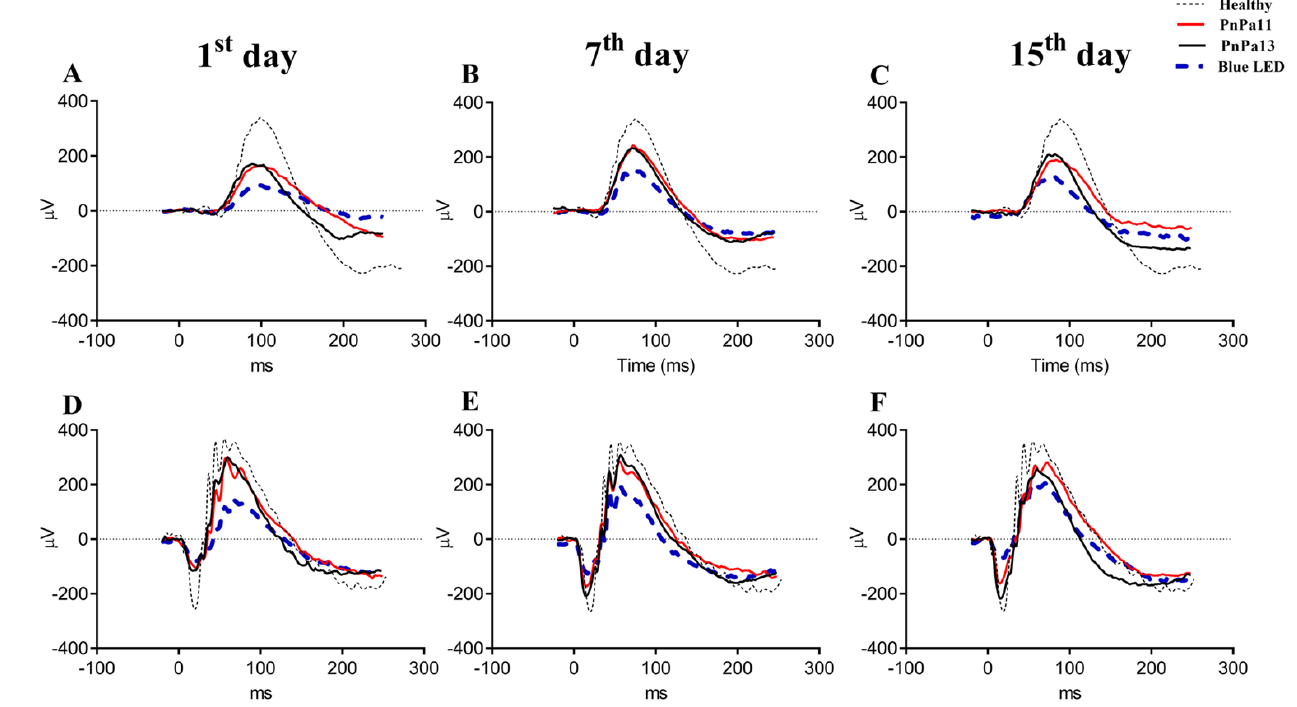
Figure 3. ERG curves at scotopic condition under luminous intensity of (A-C) 0.01cd·s·m −2 and (D-F) 3.0 cd·s·m −2 . ERG responses were recorded (A, D) 1, (B, E) 7 and (C, F) 15 days after blue LED light exposure. ERG curves of eyes treated with saline, PnPa11 (1.25 µg/mL), and PnPa13 (1.25 µg/mL) were compared with the healthy group (n = 8). The pattern of ERG curves was analyzed by the Shapiro-Wilk test succeeded by Kruskal-Wallis and the post-test of